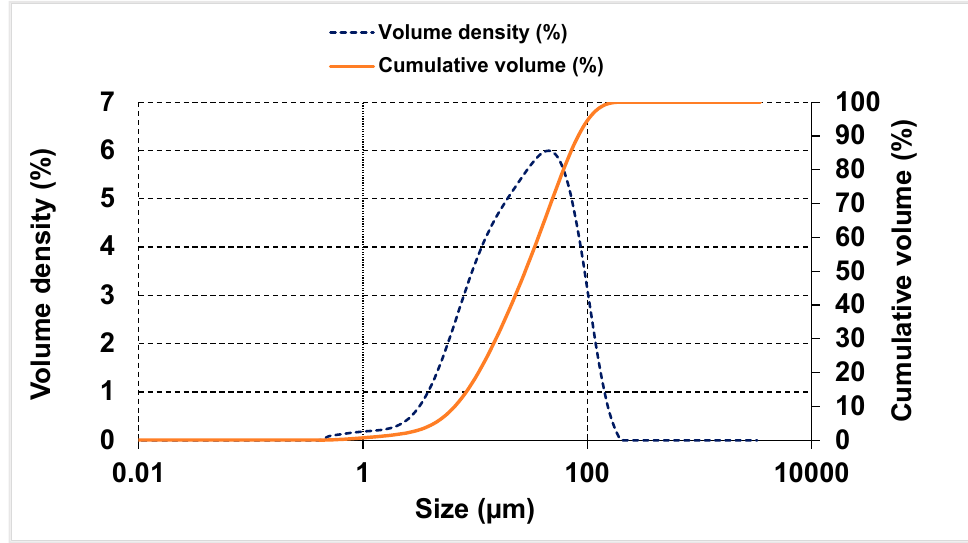
Figure 1. Particle size distribution and volume density plots for bentonite.